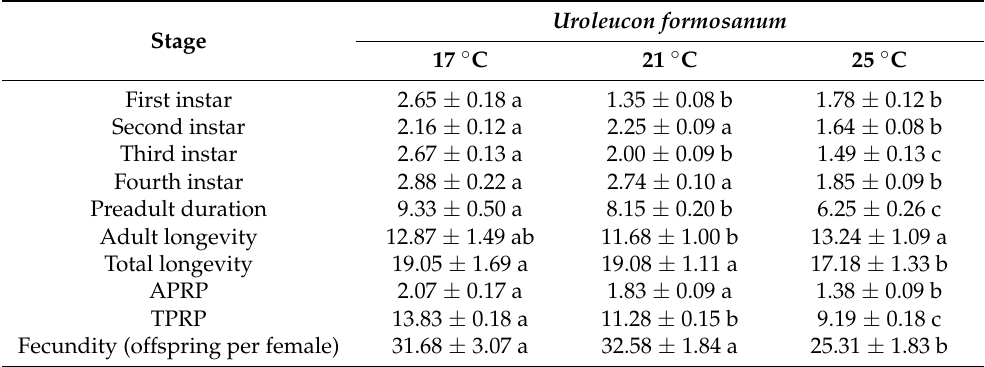
Table 1. Developmental duration and fecundity of Uroleucon formosanum under different temperatures.